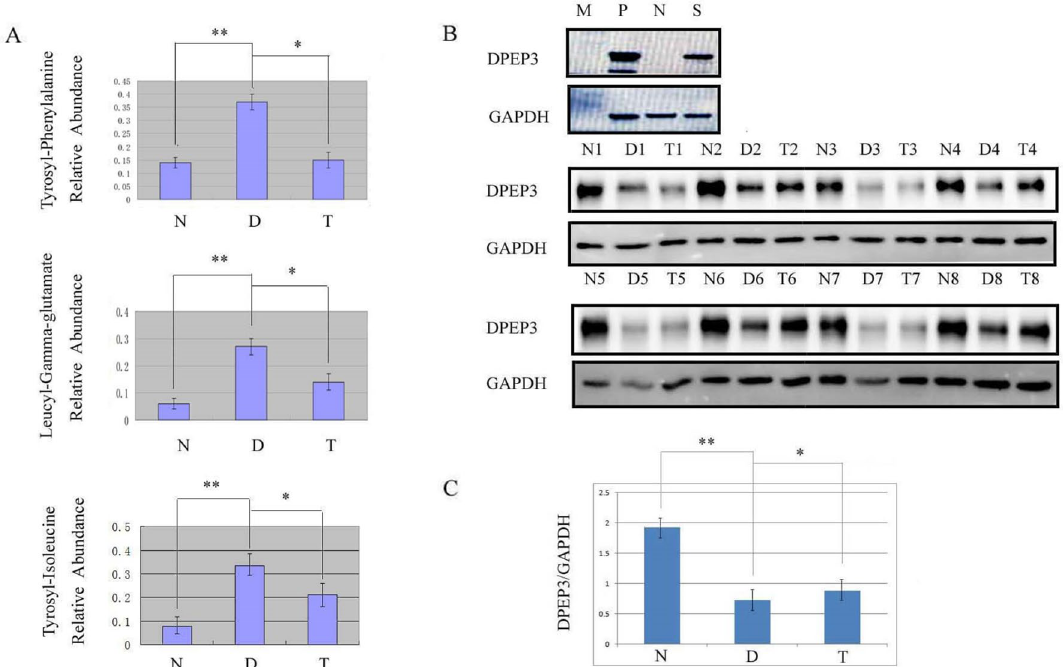
expression among the normal control group, varicocele group and varicocelectomy group. Blots were distributed on three different gels. Electrophoresis, hybridization and exposure were performed under the same conditions. The intensity of the bands was analyzed by Image J software, and t-test was used for statistical analysis. Panel C shows statistical results for each group. P: positive control, N: negative control, S: sample, N: normal control group, D: varicocele group, T: varicocelectomy group. ** P < 0.01; * P <